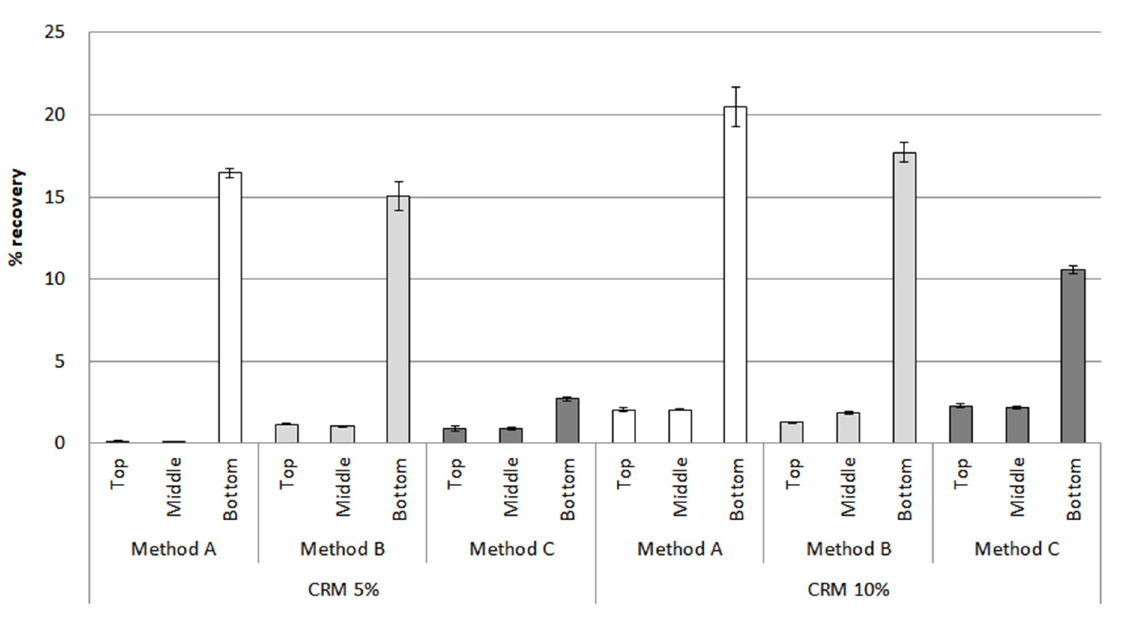
Figure 14. The percentage recovery (3.2 kPa) of the CRM asphalt binders for each mixing method in the top, middle, and bottom parts, after